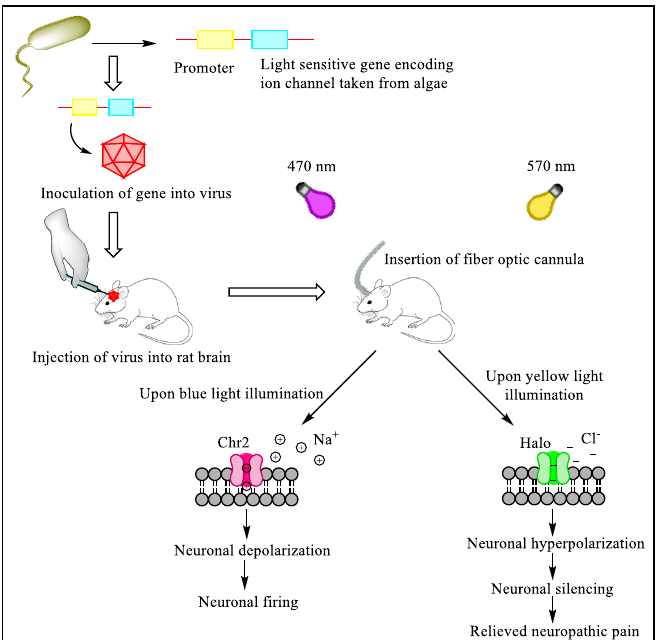
Figure 7. Optogenetic modulation of pain perception. Algal opsin (‘light-sensitive’ gene encoding ion channel) combined with the optogenetic actuator (promoter) is inoculated into a virus. This virus is delivered into the rat brain, where this light-sensitive ion channel expression takes place in neurons upon light illumination at particular wavelengths. At 570 nm, yellow light activates halorhodopsin, which ultimately leads to neuronal silencing and provides relief from neuropathic pain. Channelrhodopsin, Chr2; halorhodopsin, Halo.